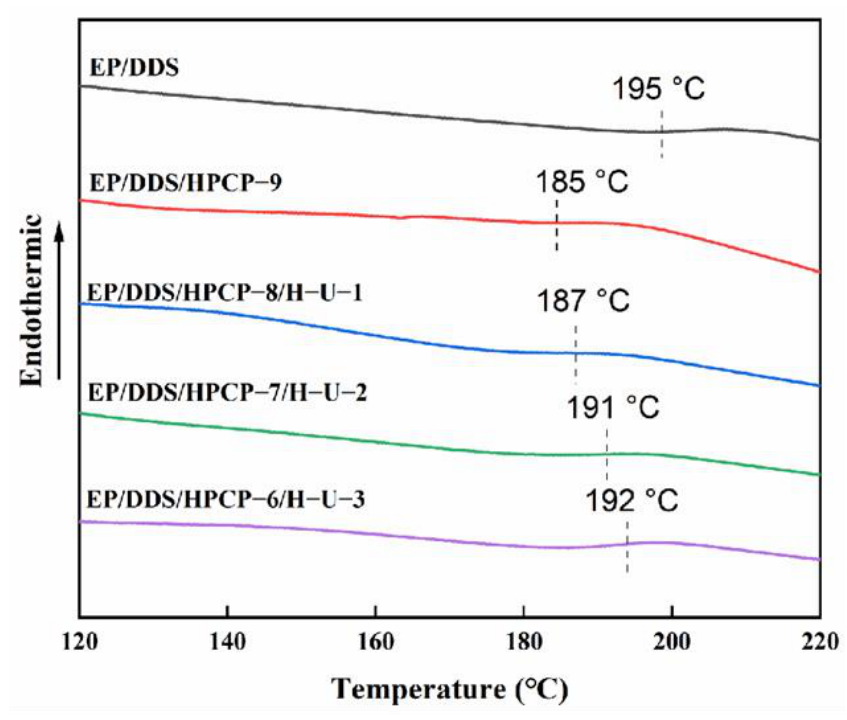
Figure 4. T g s of EP and its composites obtained by DSC.